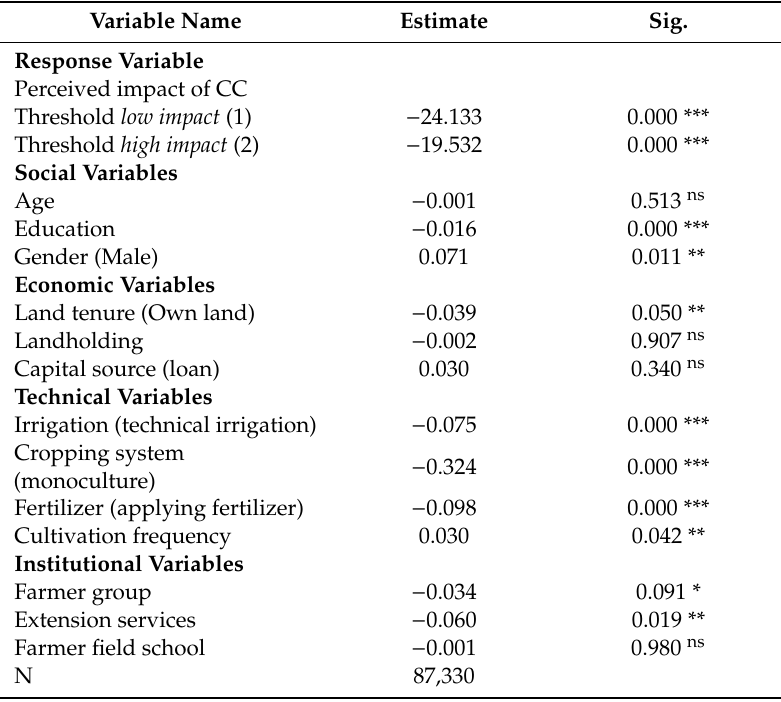
Table 2. The estimation